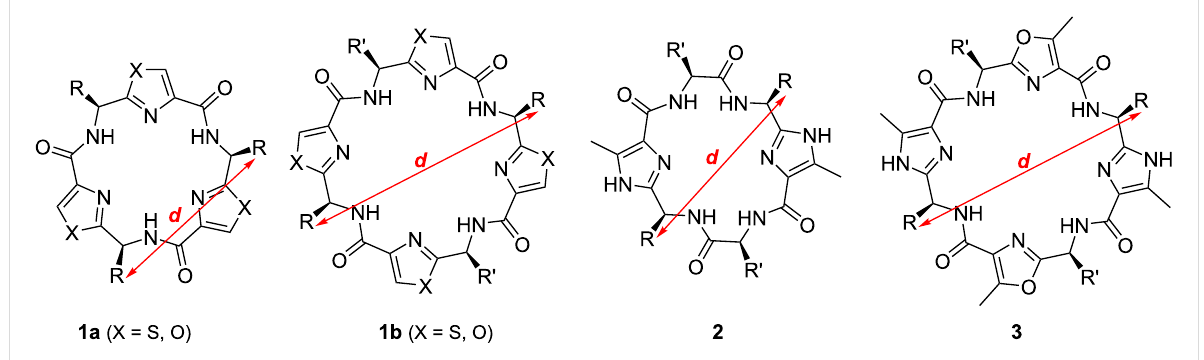
Figure 1: Some examples for artificial C 2 - and C 3 -symmetric platforms based on Lissoclinum cyclopeptide alkaloids.